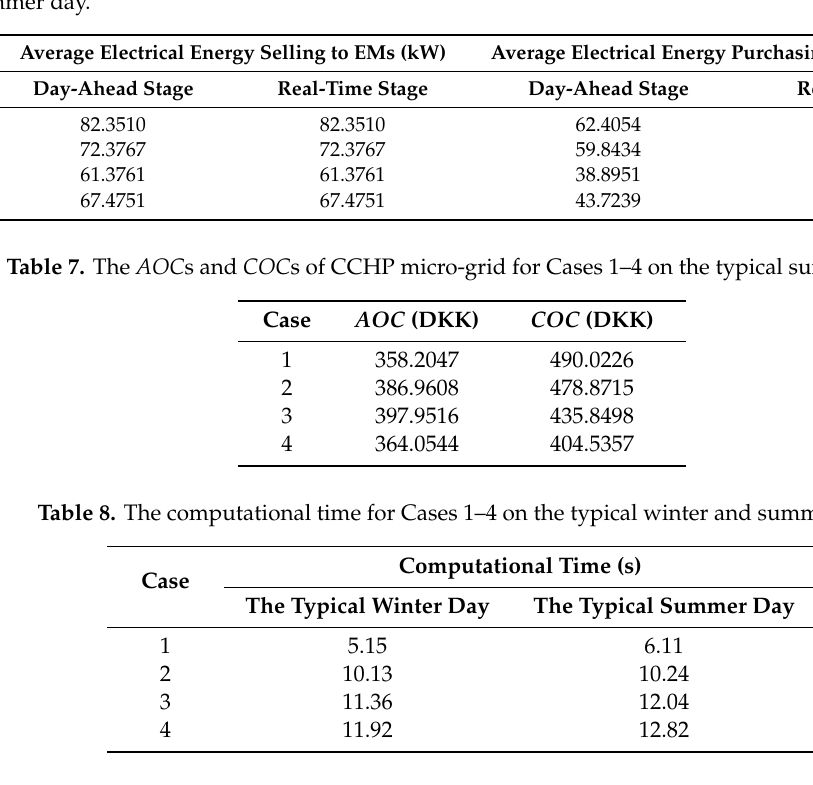
Table 6. Average electrical energy selling to and purchasing from EMs in Cases 1–4 for the typical summer day.